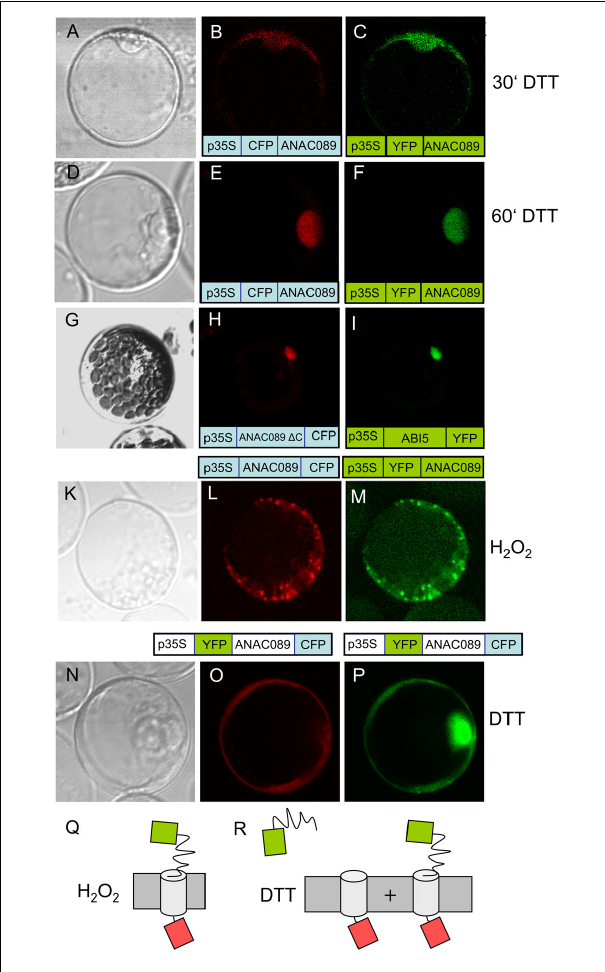
FIGURE 5 | Redox-dependent dynamics ofANAC089 localization. (A – F) Time-dependent localization of ANAC089 was documented following a treatment with dithiothreitol (10 mM DTT). Images were taken at t = 30 min (A – C) and t = 60 min (D – F) . (A, D) Bright field image. (B, E) Fluorescence signal of N-terminally fused CFP (ANAC089-CFP). (C, F) Fluorescence signal of N-terminally fusedYFP (ANAC089-YFP). (G – I) Nuclear accumulation of ANAC089 lacking the transmembrane domain. Protoplasts were transformed with the 3 (cid:3) -truncated ANAC089 coding for a variant that lacks the C-terminal membrane domain (total remaining length 298 aa, see Figure 3A , red arrow). In parallel the protoplasts were transformed with ABI5 expression construct. Both fluorophore-fused proteins localized to the nucleus. (K – M) Localization of N-terminally fused fluorophores in response to H 2 O 2 . Protoplasts of A. thaliana were treated with 5 mM H 2 O 2 for t = 60 min. (K) Bright field. (L) ANAC089:CFP-signal. (M) ANAC089:YFP-signal. (N – P) Translocation of ANAC089 to the nucleus following reductive activation with 10 mM DTT for 60 min. In this case a double fusion was used, namelyYFP:ANAC089:CFP under control of the p35S. (N) Bright field image. (O) CFP signal of the membrane-associated domain. (P) YFP signal of the cleaved N-terminal domain of the ANAC089-YFP in the nucleus.The transfection experiments were repeated three times with 70–90% of the successfully transformed protoplasts showing the same result. (Q,R) Schematics of underlying model explaining release ofYFP to the nucleus following cleavage: CFP in each case rests at the membrane due to its fusion to the membrane-residing helix.The N-terminally fusedYFP also rests at the membrane under oxidizing conditions (M) , or is partially or fully released with time under reducing conditions which cause cleavage of the ANAC089 domain from the membrane anchor (P) .